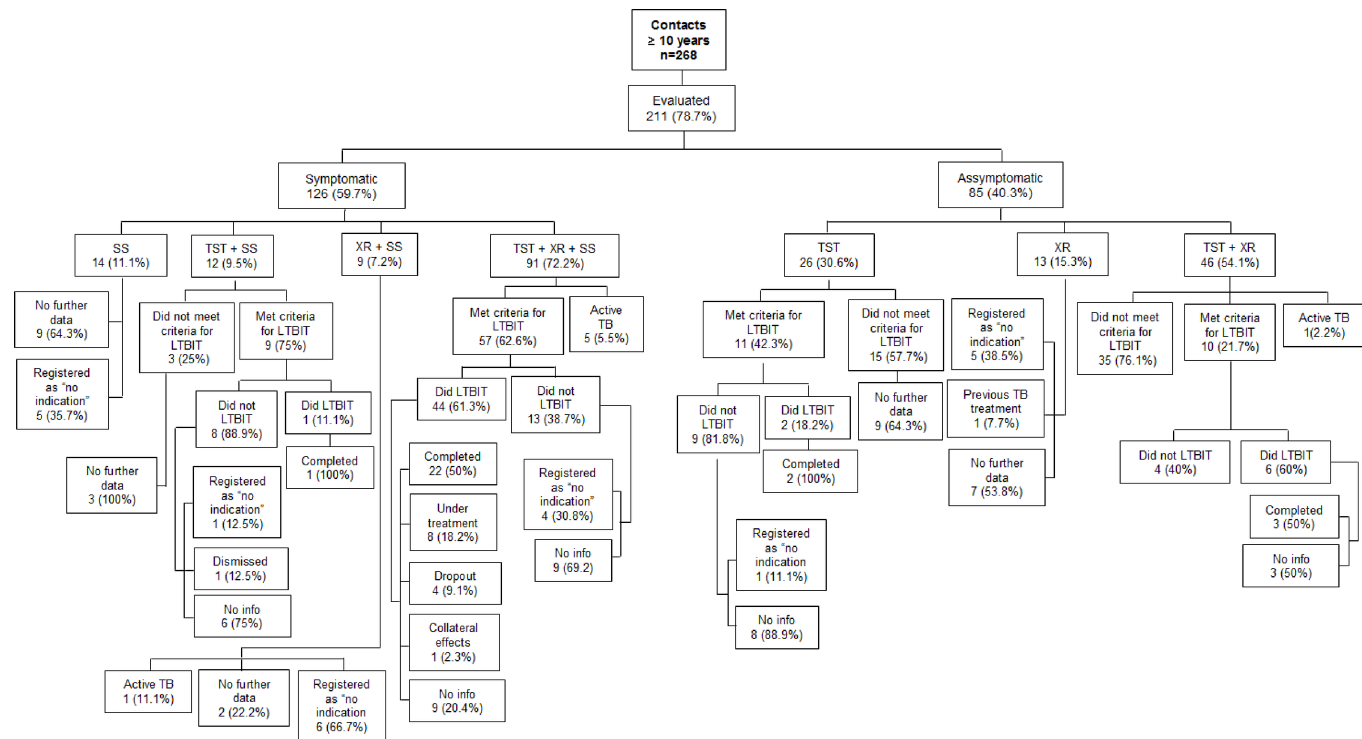
Fig 3. Description of the outcomes of the contact investigation for individuals older than 10 years old, Sao Jose do Rio Preto- SP, Brazil, 2012 – 2013.